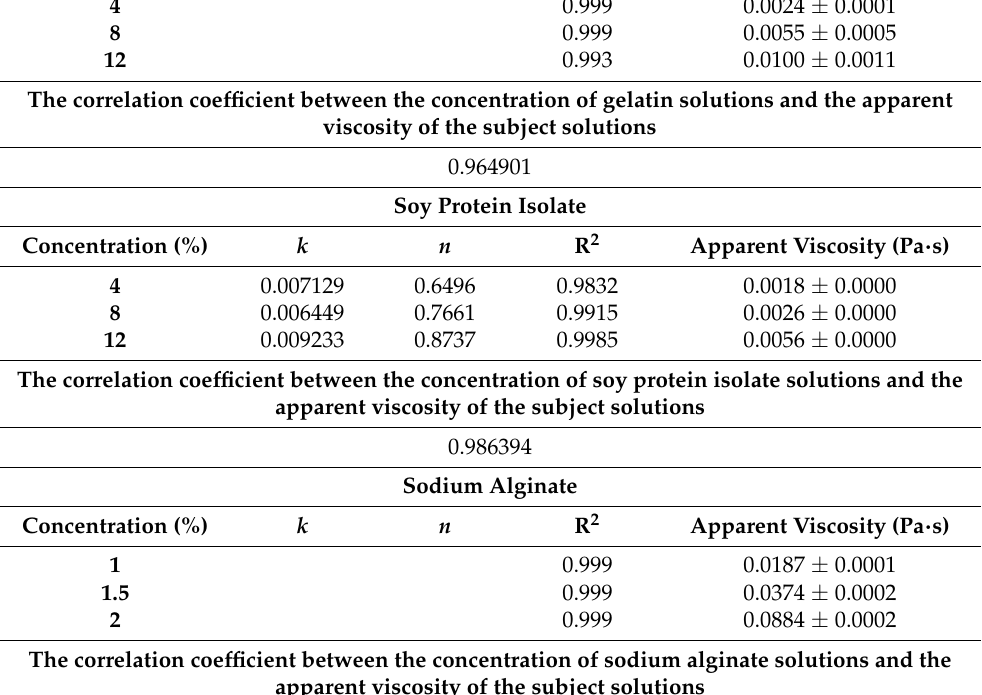
Table 2. Rheological parameters and results of correlation analysis of tested solutions of selected hydrocolloids. Concentration